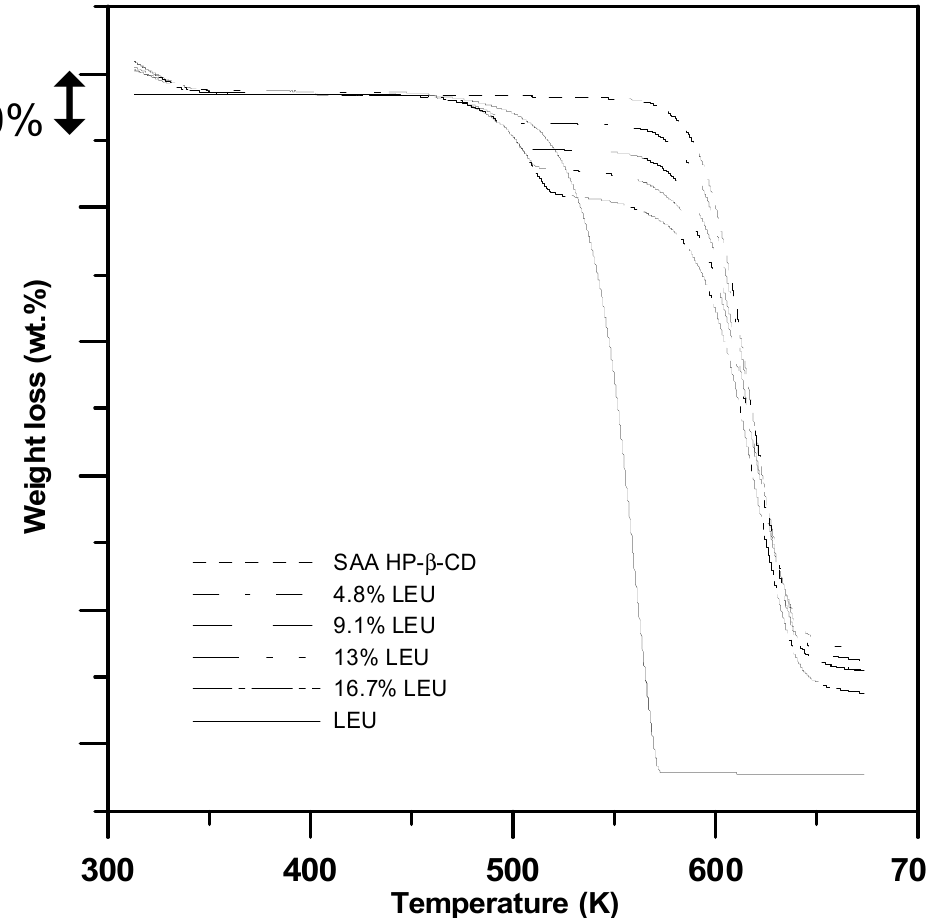
Figure 9. TGA analyses of the HP- β -CD carrier particles with varying amount of LEU (mass%) produced through SAA.